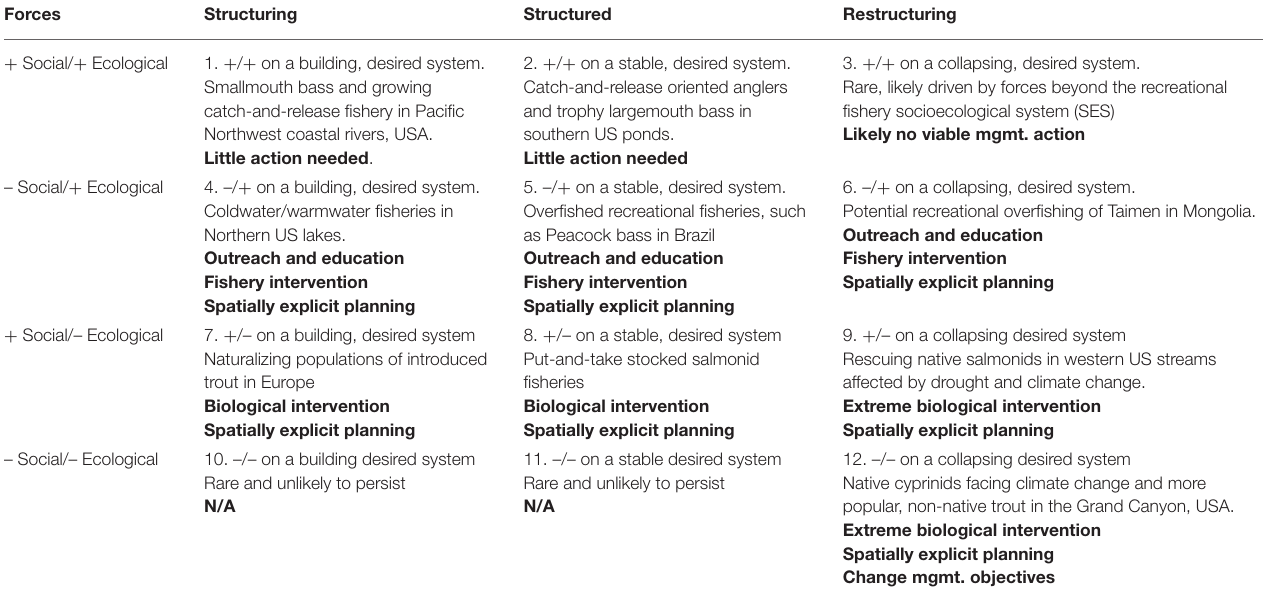
TABLE 2 | Examples and likely viable management strategies (in bold) for socioecological forces (rows) and resilience stages (columns) relevant for a desired management focus. Forces Structuring Structured Restructuring + Social/ +